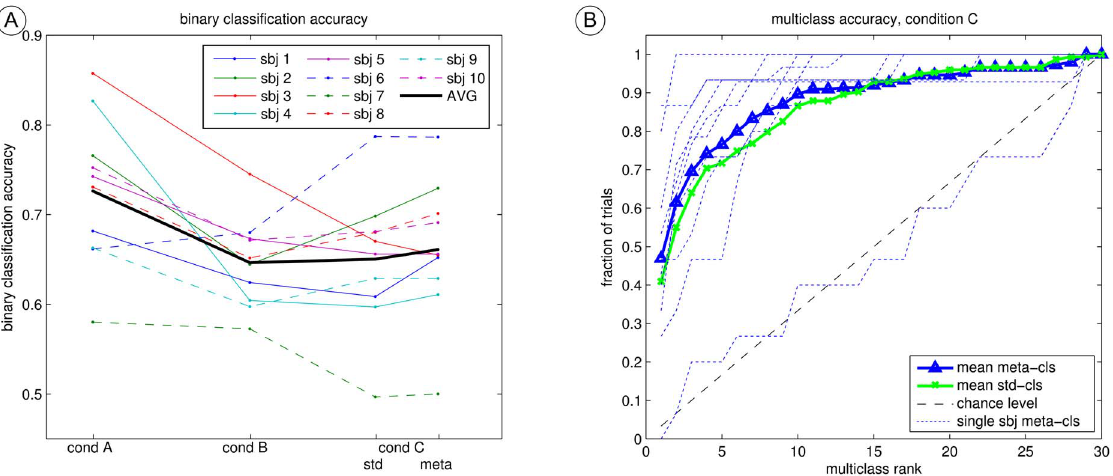
Figure 6. Classification accuracy for the calibration data of three conditions. The binary classification accuracy, estimated with cross validation is plotted for each condition and subject (A). The thick black line marks the mean. Plots B depicts the multi-class accuracy for the two classification approaches (‘‘std’’ and ‘‘meta’’). This was estimated by cross-validation on calibration data, using entire trials as test sets. Precisely, the point for rank= i quantifies the fraction of trials with a rank of the target class equal or lower than i . Thus, the mean multi-class performance (correct decision – rank=1) was 47% (41%) for the meta (std) classifier. One can observe that 77% (72%) of the trials have a multi-class rank better or equal than 5. While perfect BCI control (each 30-class decision is correct) would result in a straight line with y=1, the dashed line marks the multi-class